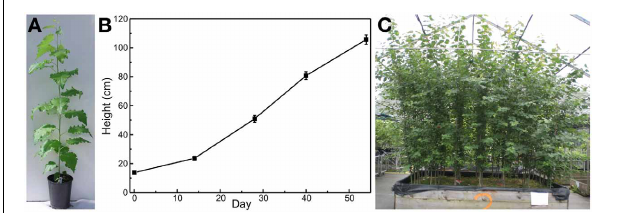
FIGURE 4 | Populus × canescens plant grown outdoors (A), height development during the growth phase of 54 days (B), and long-term growth in soil filled boxes (C). The potted poplars were grown in 3l pots from the day of planting to day 54 (mean ± SE, n = 16).